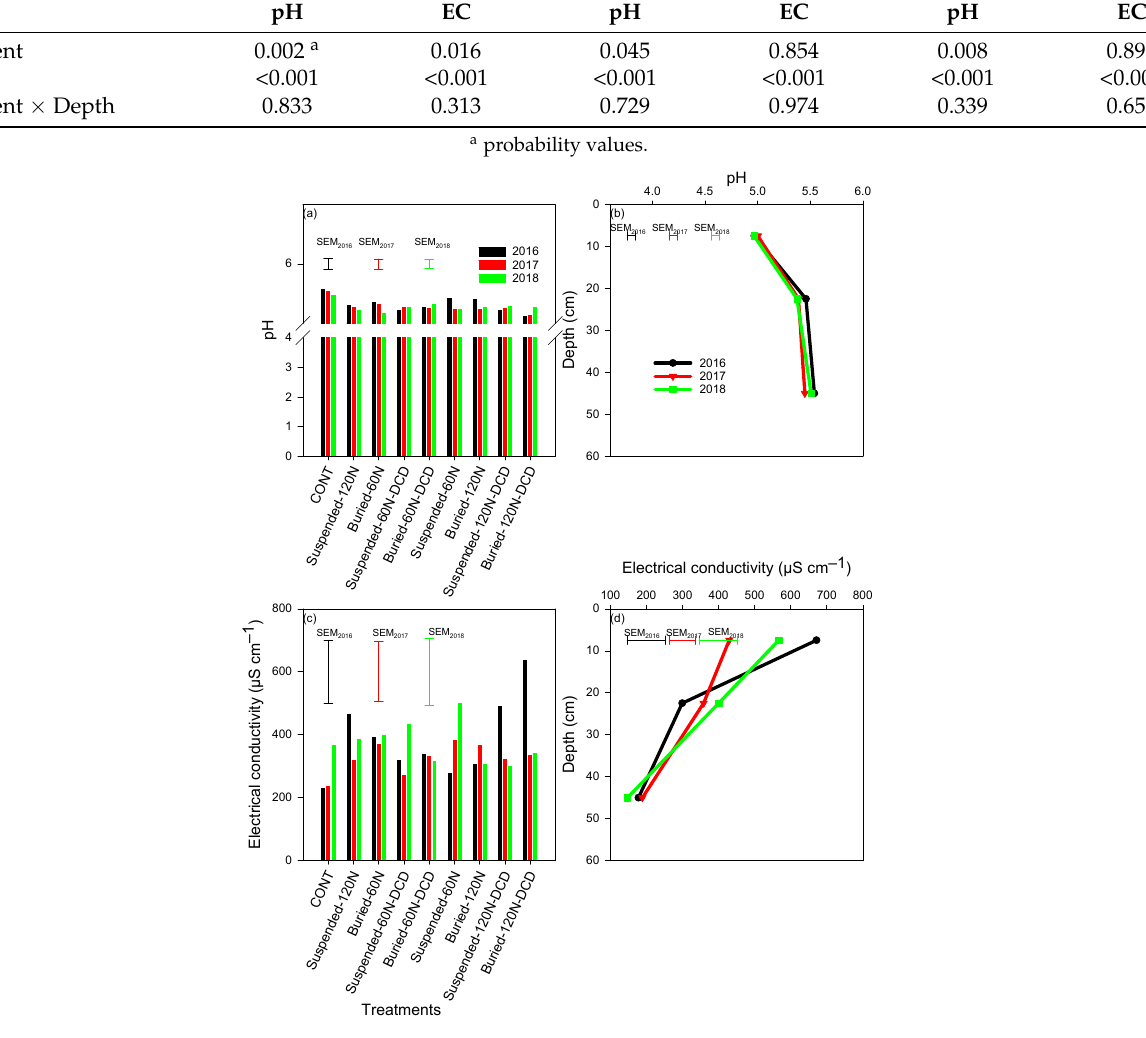
Figure 5. ( a , b ) Soil acidity (pH) and ( c , d ) electrical conductivity (EC, µ S cm − 1 ) with annual applica- tions of combination of nitrogen fertilizer and nitrification inhibitors (2-chloro-6-(trichloromethyl)- pyridine (Nitra-pyrin), di-cycandiamide (DCD)) in soils collected in fall at different depths (0–15 cm, 15–30 cm and 30–60 cm) in 2016, 2017 and 2018 in a long-term blueberry experiment (N =